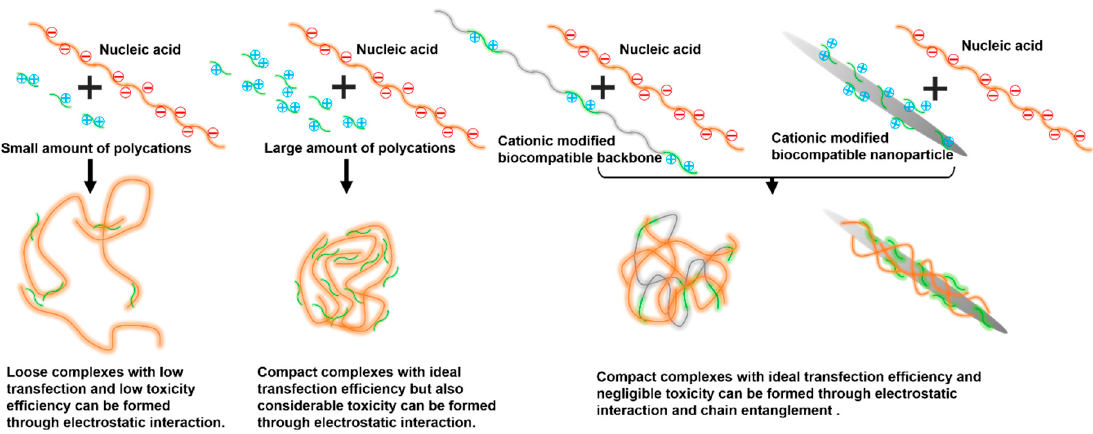
Figure 2. Possible structural models of the interaction between cationic compounds and nucleic acids.